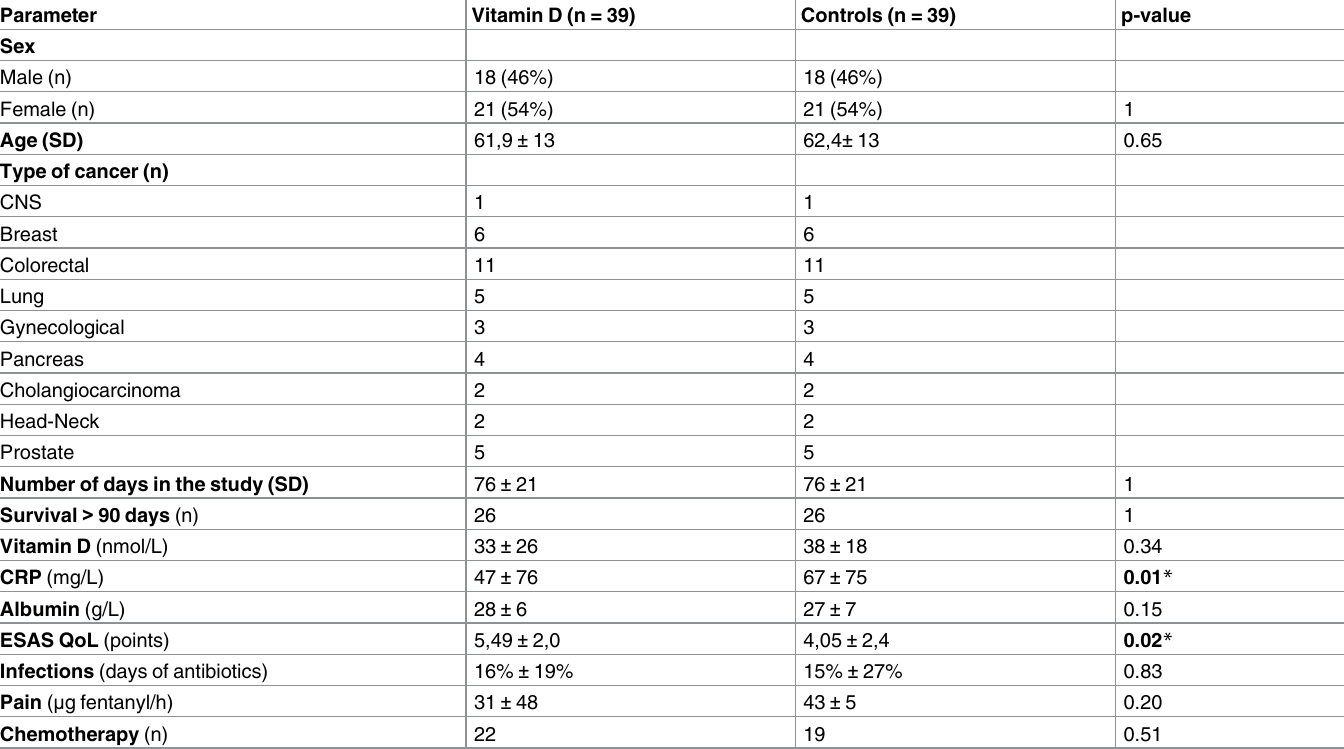
Table 1. Baseline demography of vitamin D treated patients and untreated controls. The figures show total number and percentage or mean ± SD. Parameter Vitamin D (n = 39) Controls (n = 39)